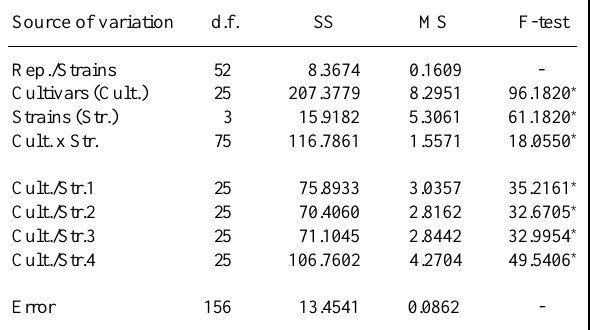
Table I - Analysis of variance for the number of galls resulting from inoculation of soybean cultivars with four strains